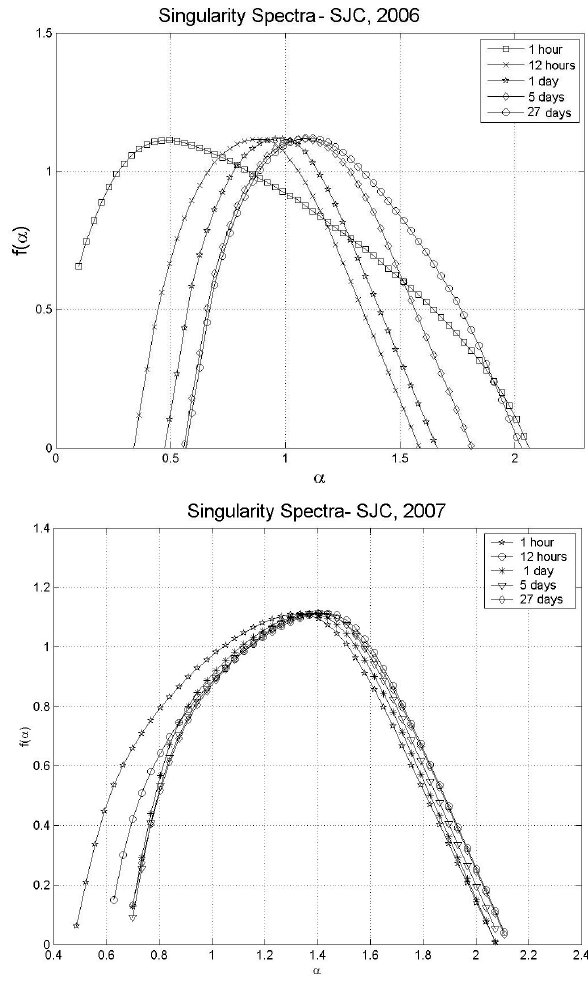
Fig. 5. Singularity spectrum for characteristic time scales shown in Figure 5: Singularity spectrum for characteristic time scales shown in legend for SJC, 452 legend for SJC, 2006 and 2006 and 2007 years. 453